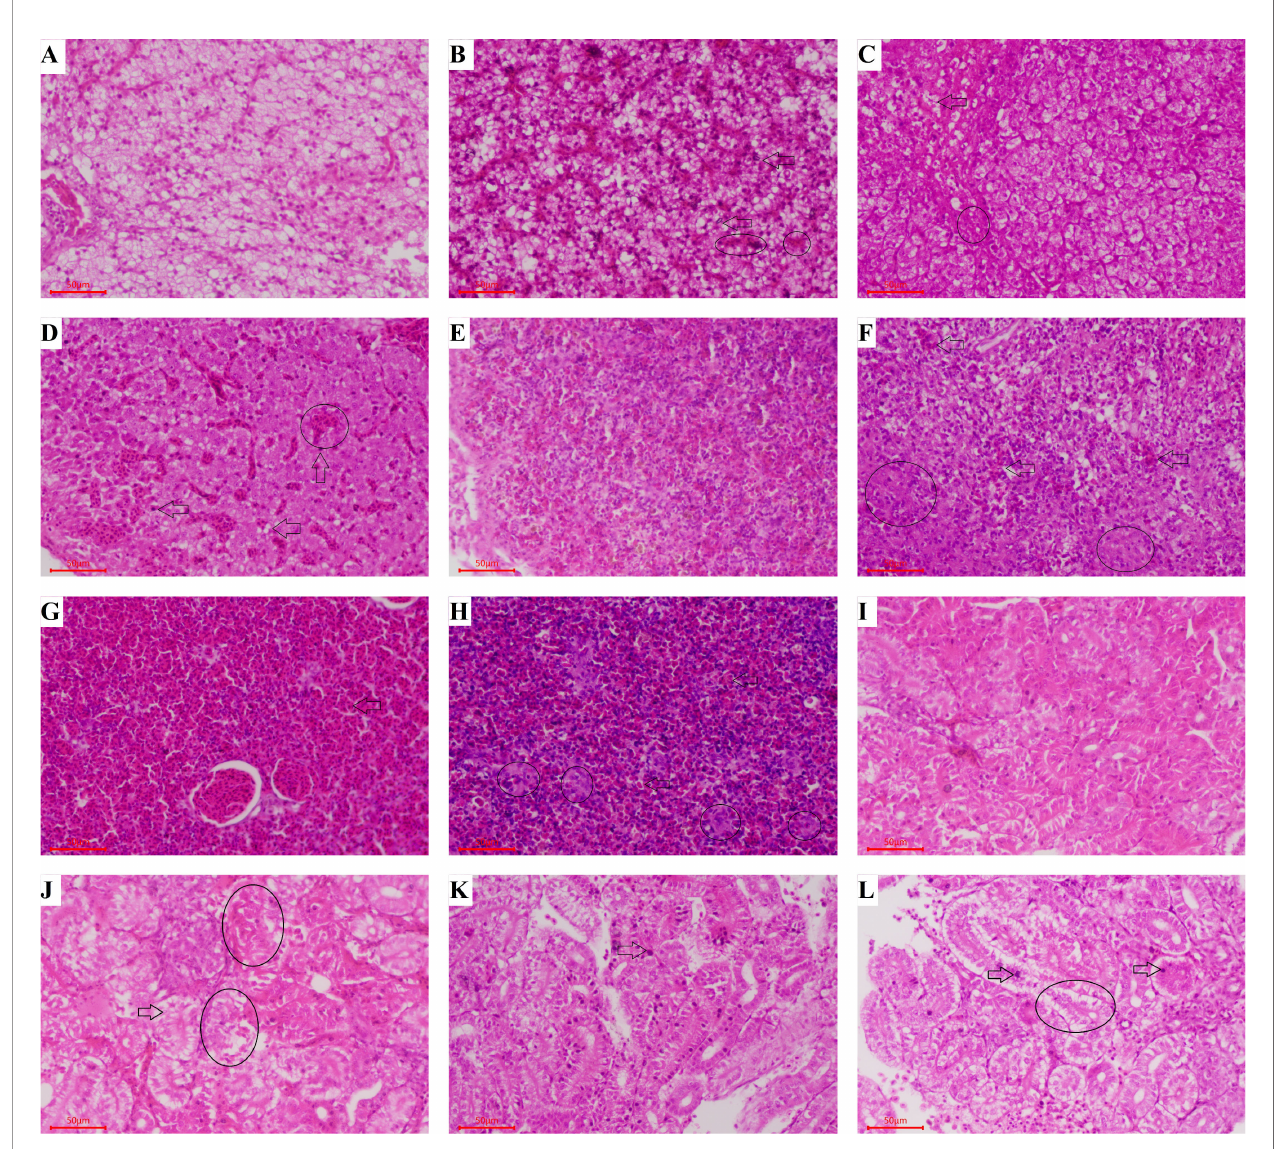
FIGURE 7 | Histopathological assessment of liver, spleen, and kidney from largemouth bass after challenge. Groups A, E, and I: Fed with commercial basal diet +PBS, treated with no virus; Groups B, F, and J: Fed with commercial basal diet+10 7 CFU/g GS115-pW317-MCPD, challenged with LMBV; Groups C, G, and K: Fed with commercial basal diet+10 8 CFU/g GS115-pW317-MCPD, challenged with LMBV; Groups D, H, and L: Fed with commercial basal diet+PBS, challenged with LMBV. (A) The structure of liver cell was integrated, and the gland was clearly visible. (B) Some hepatocytes were swollen and degenerated ( ⇨ ), the chromatin edges are concentrated and moved into rings (O). (C) Hepatic cell swelling and vesicular degeneration were detected ( ⇨ ), the chromatin edges are concentrated and moved into rings (O). (D) Hepatic sinus dilatation and congestion ( ⇨ ), hepatic cell swelling and vacuolar degeneration and steatosis were found (O). (E) The spleen cells were normal with intact structure, and no pathological changes were found. (F) The splenic sinus was diluted and fi lled with pink serous fl uid, a small amount of reticular cellulose and a large number of red blood cells were detected ( ⇨ ), spleen structure is disordered and reticular cells increase (O). (G) Some congestive spleen cells were found ( ⇨ ). (H) Spleen sinuses were dilated and congested (O), a large number of red blood cells were detected in the spleen tissue ( ⇨ ). (I) The kidney cells were normal with intact structure. (J) Swelling and degeneration of renal tubular epithelial cells were detected ( ⇨ ), tubule epithelial cells were swollen and separated from the basal side of the renal tubules (O). (K) Some swelling and degeneration of renal tubular epithelial cells were detected ( ⇨ ). (L) Tubule epithelial cells were highly swollen ( ⇨ ) and partially separated from the basal side of the renal tubules